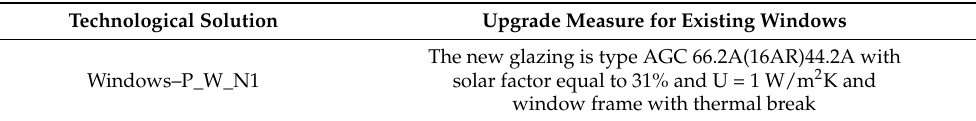
Table A16. Upgrade measure for existing windows (P_W_N1).